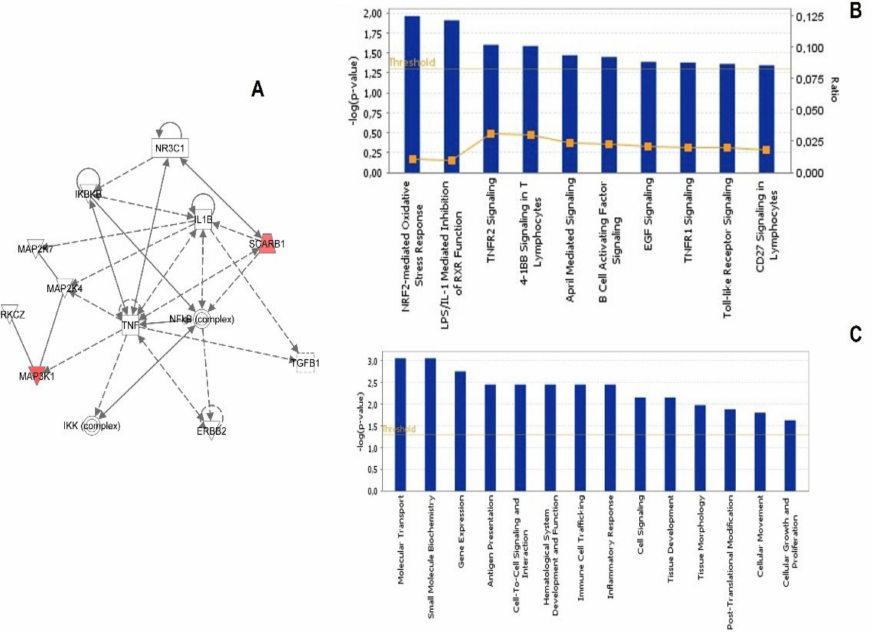
Figure 2. Ingenuity Pathways Analysis (IPA) summary. To investigate possible interactions of differently regulated genes, datasets representing 21 genes with altered expression profile obtained from the Illumina microarray were imported into the Ingenuity Pathway Analysis Tool, and the following data are represented: ( A ) The network analysis of the most highly rated network (cell death, cellular development, and hematopoiesis). Genes shaded in red were determined to be significantly regulated from the statistical analysis and were validated by real-time PCR. A solid line represents a direct interaction between the two gene products and a dotted line means there is an indirect interaction. ( B ) Pathway analysis. The top canonical pathways with p -values ranging from 1.01 × 10 − 2 to 3.26 × 10 − 2 are represented. ( C ) Biofunction annotations. The x-axis represents the top biological functions as calculated by IPA based on differentially expressed genes, and the y-axis represents the ratio of number of genes from the dataset that map to the pathway and the number of all known genes ascribed to the pathway. The yellow line represents the threshold of p < 0.05 as calculated by Fischer’s